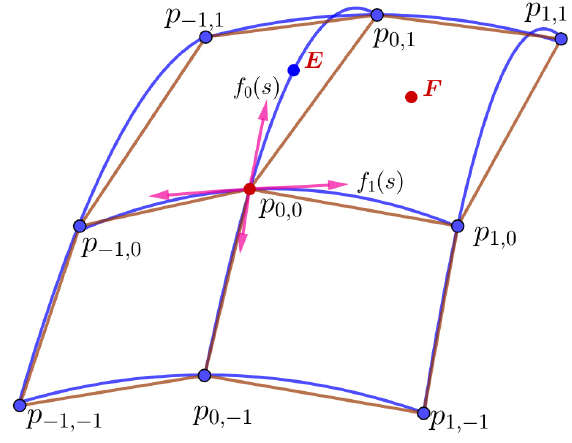
Figure 12. Notations for the continuous proof at a regular vertex.